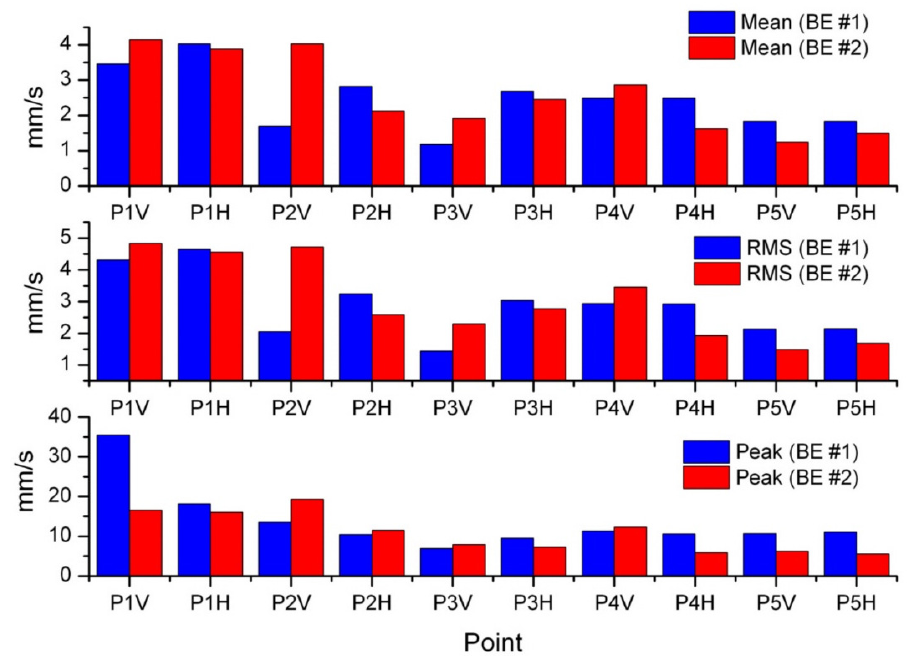
Figure 6. Mean, RMS and Peak values of vibration velocity in the drive units of the tested bucket elevators BE#1 and BE#2.